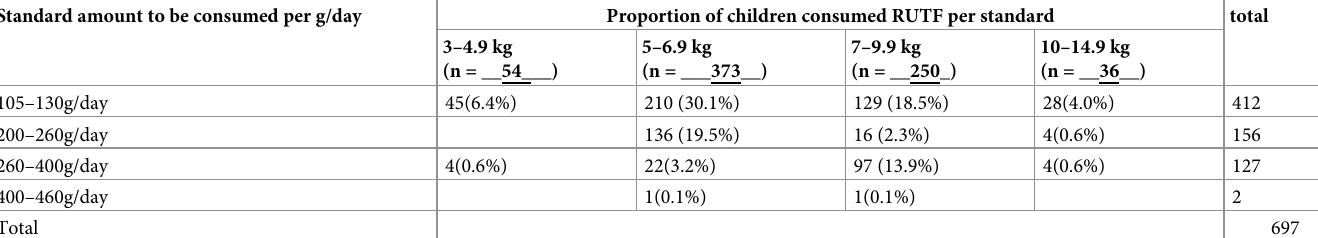
Table 4. Comparison of the study result with the standard of therapeutic food to be consumed.